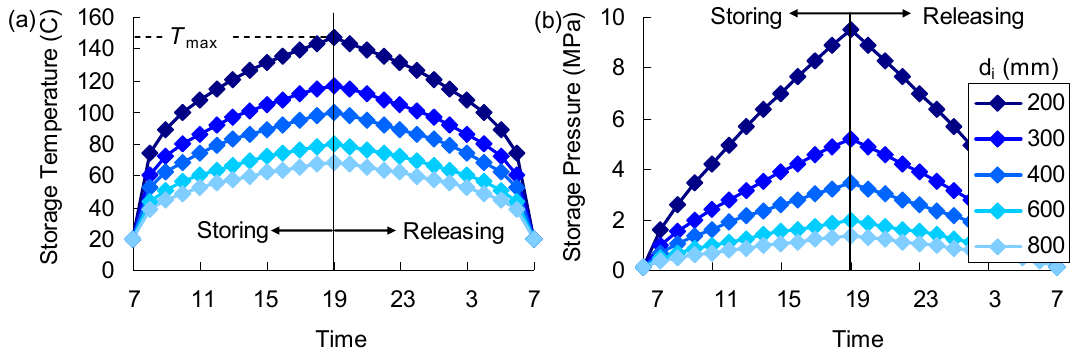
Figure 4. One day energy storage cycle for a 2-story with 7 × 7 m column spacing: ( a ) temperature; ( b ) pressure.